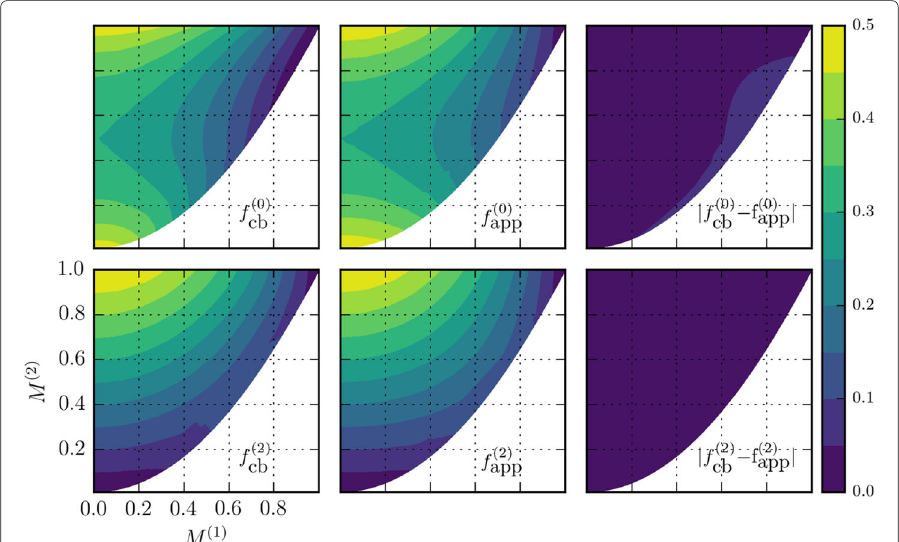
Fig. 10 Left column: the Zeroth and the second order annihilation functions as functions of M ( 1 ) and M ( 2 ) . Center column: polynomial approximations of the annihilation functions. Right column: absolute errors of the